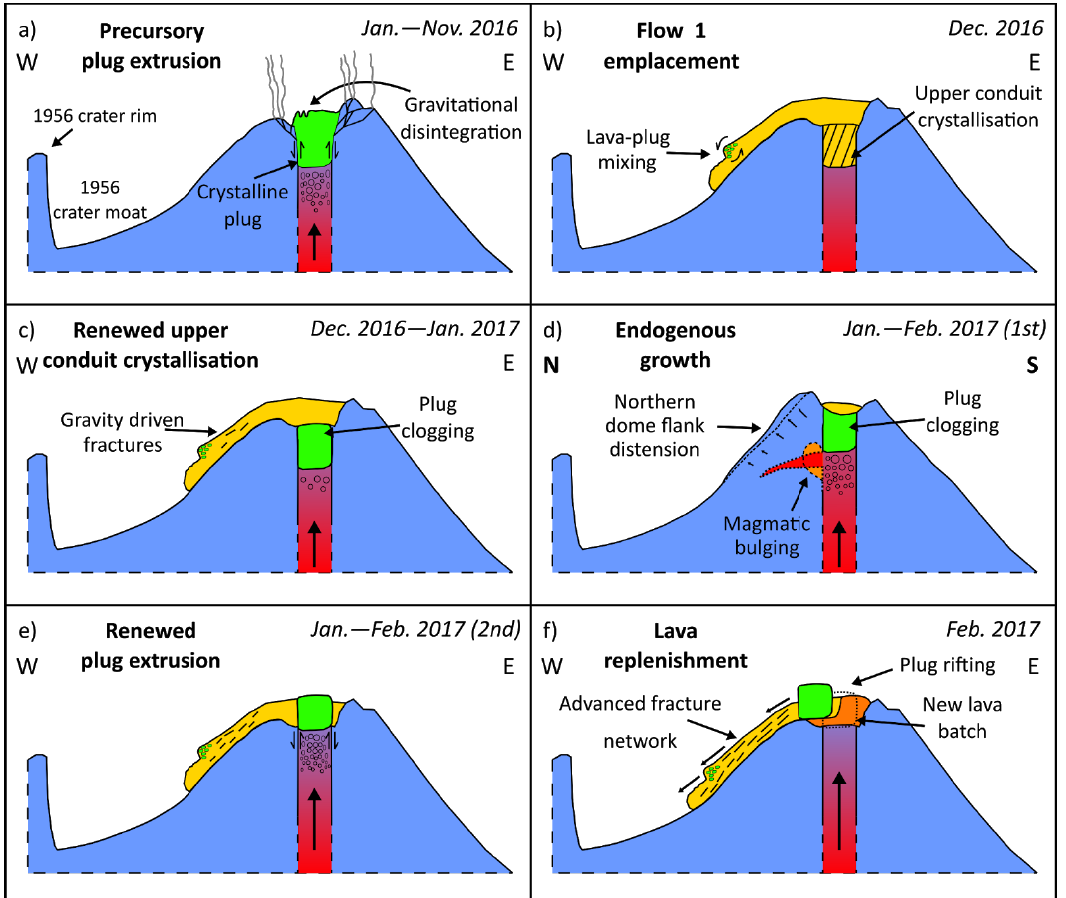
Figure 7. Schematic sketch of endogenous and exogenous growth episodes at Bezymianny. ( a ) Plug extrusion accompanied with degassing through a pre-existing, reactivated fracture network. Circles indicate gas pressurisation, ellipses show shearing at the conduit walls. ( b ) December 2016 lava flow emplacement and mixing of flow with precursory plug material causing significant compressional folding. The remaining magma batch in the upper conduit starts to solidify. ( c ) The new plug clogged the vent and ( d ) deflected the rising magma into distinct parts of the carapace. These mechanisms may account for all detected distension episodes. ( e ) Gas pressurisation exceeds yield strength of flow 1, and the previously formed new plug extruded. ( f ) Lava replenishment pushed the new plug and flow 1 westwards, which caused enhanced fracturing of the lava flow. Table 1. Chronology of volcanic processes at Bezymianny between January 2016 and August 2018. The ra- and az-rates correspond to range and azimuth offset rates, respectively. FOV = field of view. Observation period